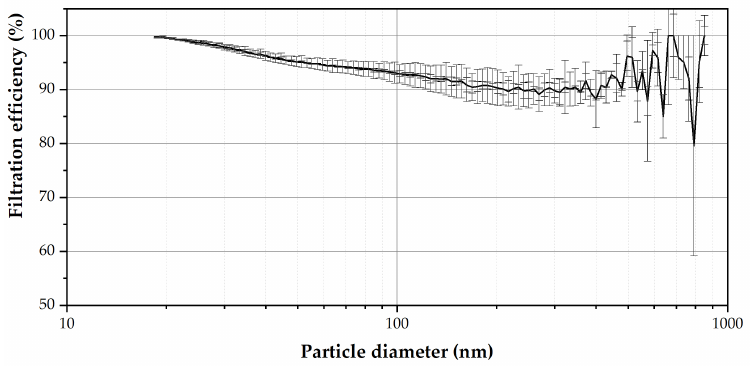
Figure 7. Evaluation of the reproducibility of the electrospinning process at similar atmospheric conditions (RH of 36–42% and a T of 20.7–22.4 ◦ C) in